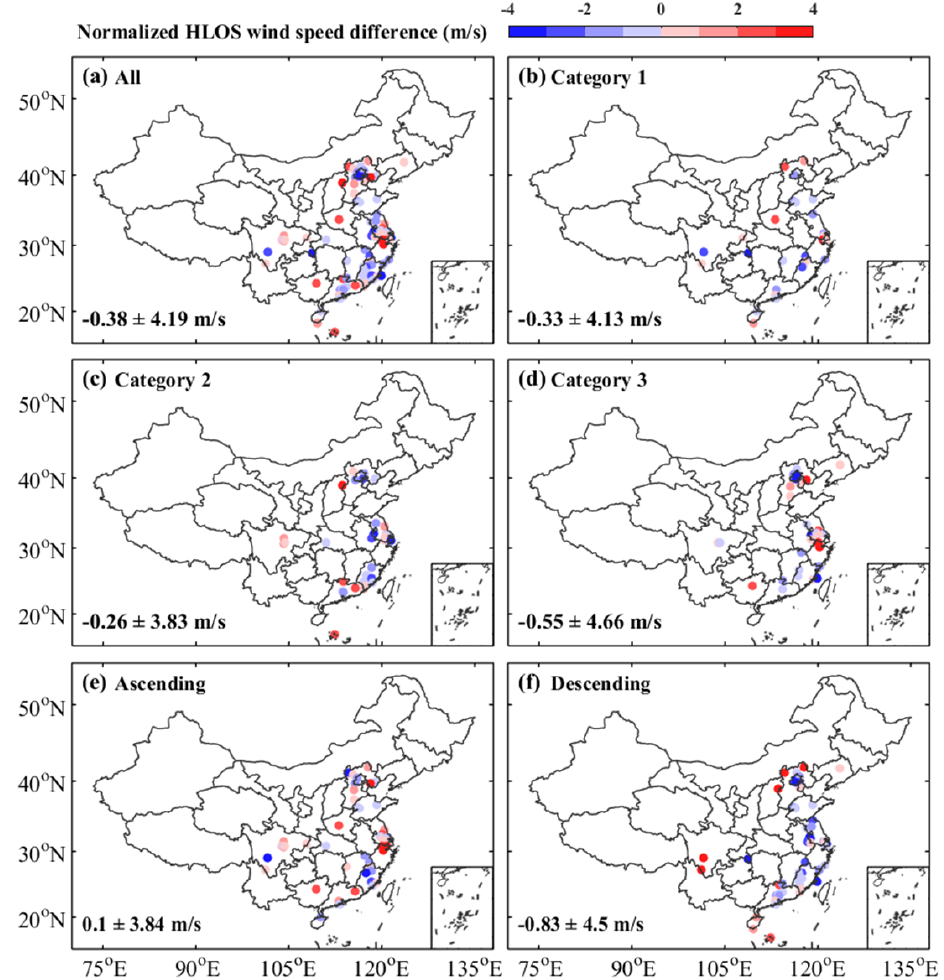
Figure 9. The geographic distribution of the normalized differences between the Aeolus HLOS and the RWP HLOS wind speeds for Mie- cloudy winds. The normalized differences are shown for all RWP sites in China (a) and for the RWP sites belonging to (b) category 1, (c) category 2, (d) category 3, (e) ascending orbits, and (f) descending orbits. The text labels represent the mean difference and standard deviation. The black circles indicate that the site passed the statistical significance difference test ( P< 0 .